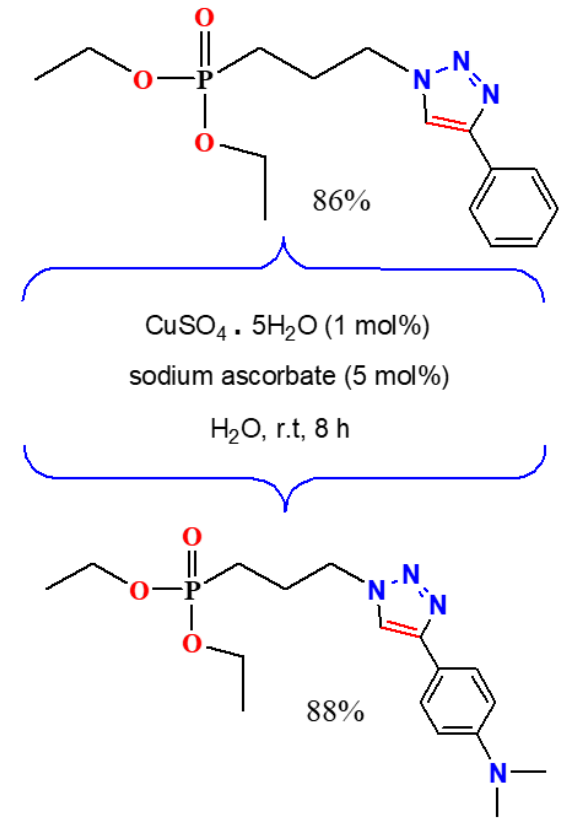
Figure 6. Azides-alkynes cycloaddition mediated by copper(II) sulfate in the presence of sodium ascorbate in water at room temperature.